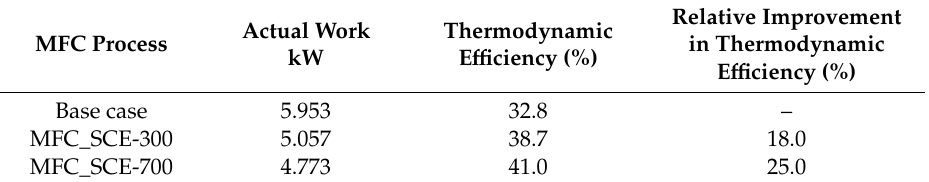
Table 7. Actual work, work lost and thermodynamic e ffi ciency of the MFC–LNG